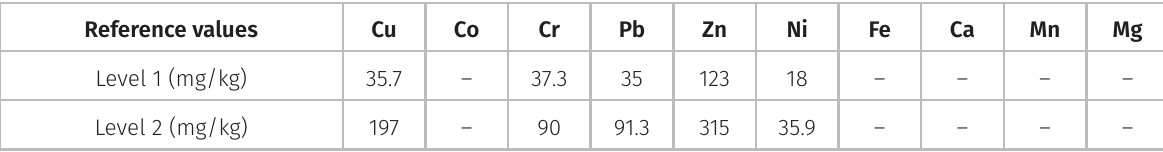
Table IV. Reference values in dry matter (mg/Kg), classification levels according to CONAMA 454/2012 and sediment quality guide values expressed as TEL (level 1) and PEL (level 2). Reference